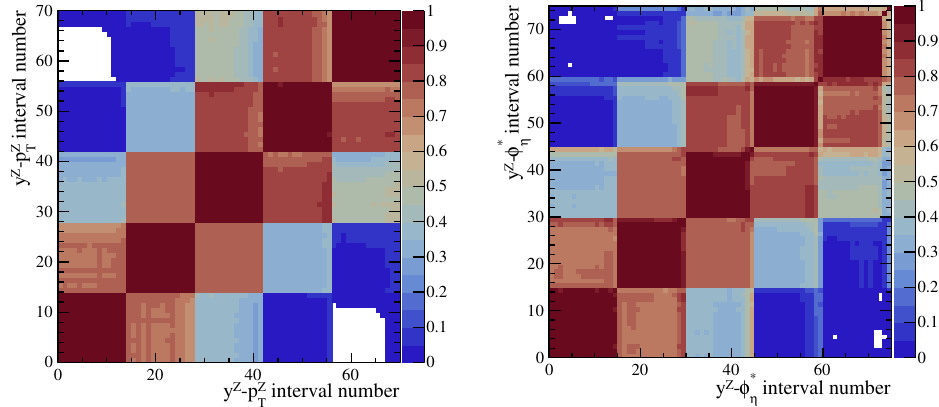
Figure 15 . Correlation matrix of efficiencies uncertainty for two-dimensional (left) y Z − p Z (right) y Z − φ ∗ measurements. More details about the ‘interval number’ can be found in table 17 η and table